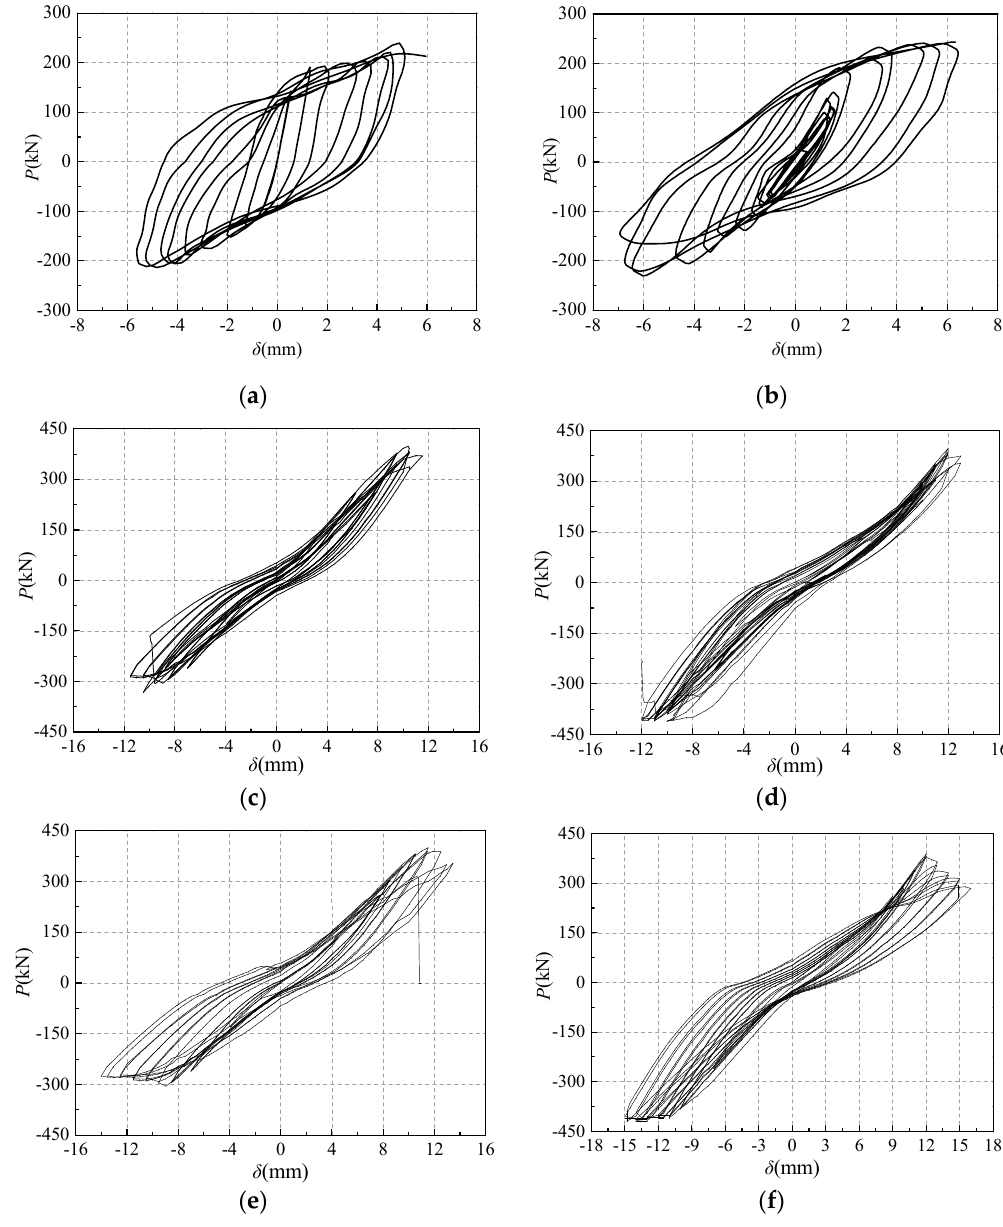
Figure 7. Hysteretic curve of the joints. ( a ) K-CC; ( b ) K-RC; ( c ) K-CCC1; ( d ) K-RCC1; ( e ) K-CCC2; ( f ) K-RCC2. ( f )